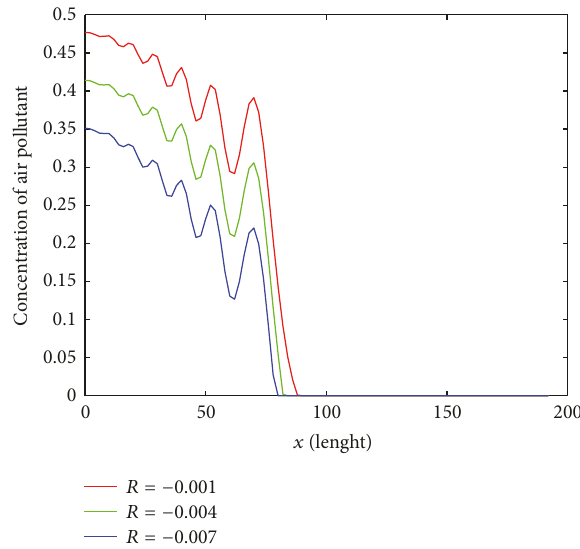
Figure 8: Compare the concentration of air pollutant where 𝑅 = 0.001, 𝑅 = 0.004 , and 𝑅 = 0.007 sec −1 .